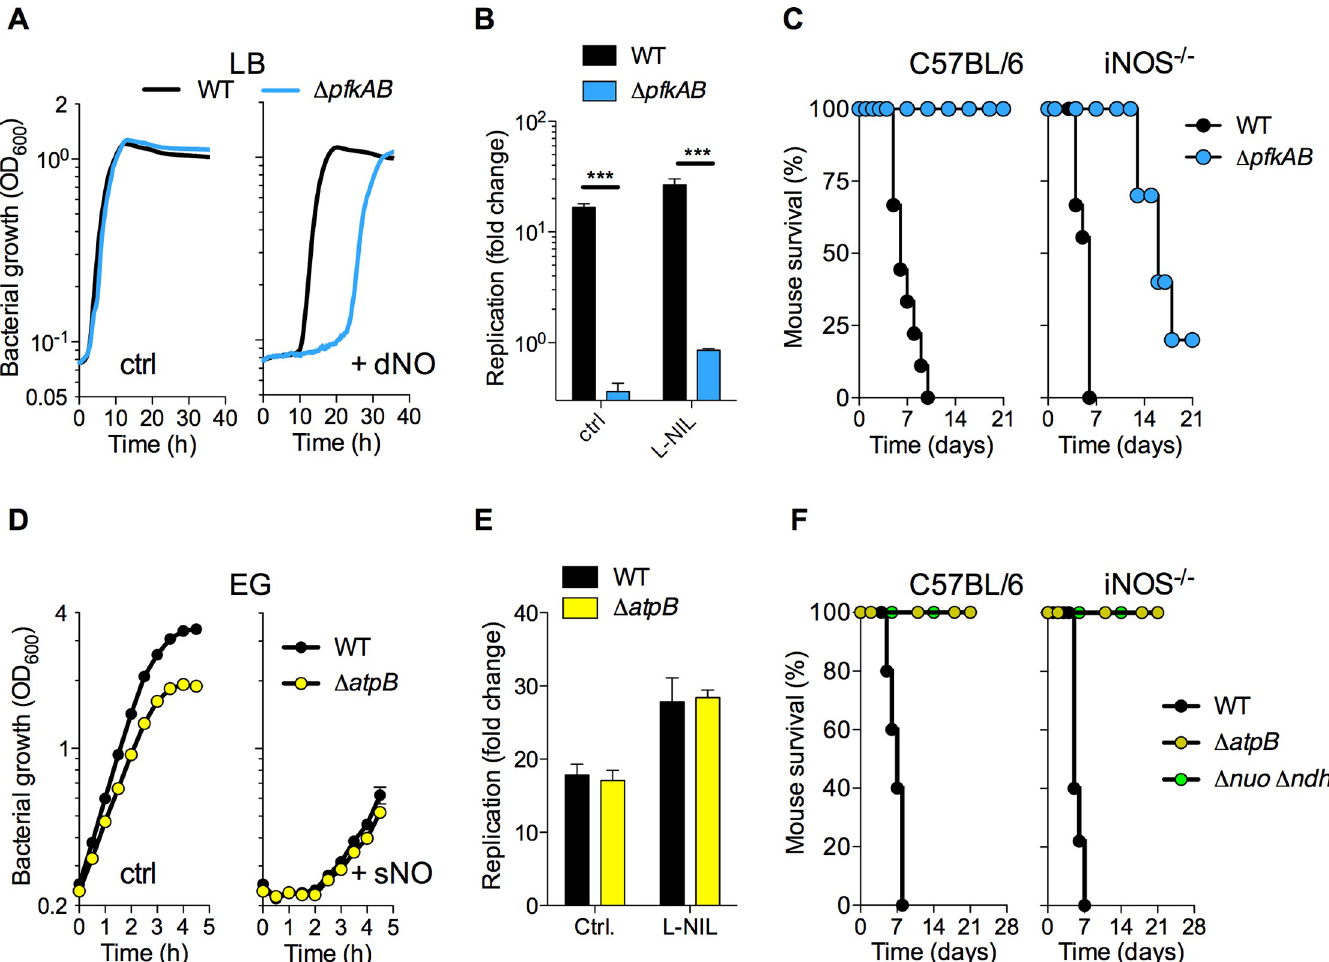
Fig 5. Glycolysis enhances the recovery of Salmonella from nitrosative stress. (A) Growth of wild-type (WT) and Δ pfkAB Salmonella in LB broth that was left untreated (ctrl) or treated with 500 μ M DETA NONOate (dNO) (N = 5, mean). (B) Intracellular replication of WT and Δ pfkAB Salmonella 20 h after challenge of J774 macrophages. Select samples were treated with 500 μ M of the iNOS inhibitor N6-(1-iminoethyl)-L-lysine (L-NIL) (N = 4–8, mean ± S.D.). ��� , p < 0.001 as determined by two-way ANOVA. (C) Survival of C57BL/6 or iNOS deficient (iNOS -/- ) mice after i . p . inoculation of 100 CFU of wild-type WT or Δ pfkAB Salmonella . (N = 9–10 mice). p < 0.01 for both C57BL/6 and iNOS -/- , as determined by logrank analysis. (D) Growth of the indicated Salmonella strains in EG minimal media. Where indicated, the specimens were treated with 750 μ M spermine NONOate (+ sNO) (N = 4, mean ± S.E.M.). (E) Replication of Salmonella in J774 macrophages in the presence or absence of L-NIL (N = 4–8, mean ± S.D.). (F) Survival of C57BL/6 and iNOS -/- mice after i . p . challenge with 100 CFU of WT, Δ atpB , or Δ nuo Δ ndh Salmonella . (N = 5 or 10